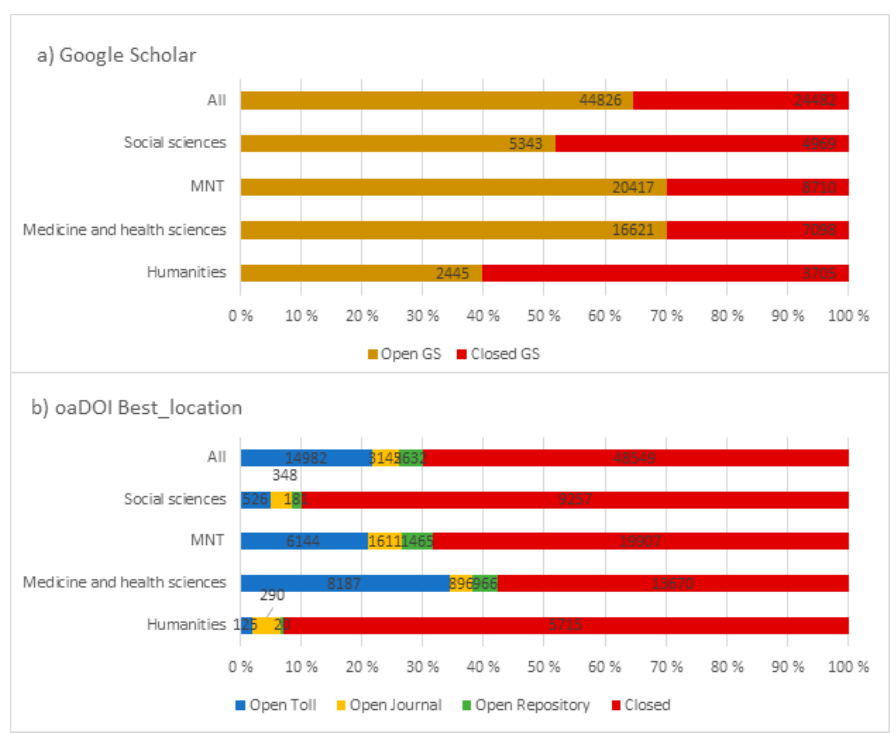
Figure 5. Open availability by subject (absolute numbers on bars) for ( a ) Google Scholar and ( b ) oaDOI Best_location for articles published between 2011 and 2015.